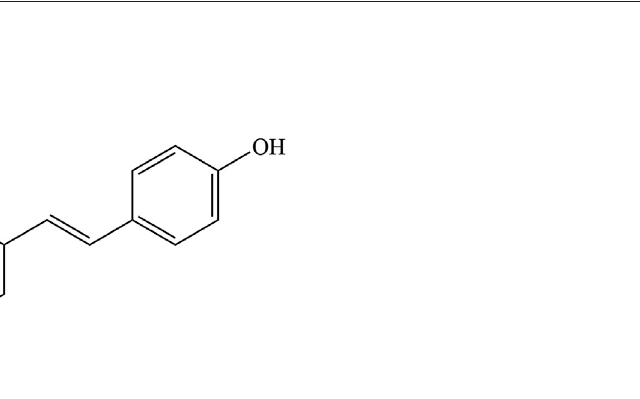
FIGURE 1 | Chemical structure of